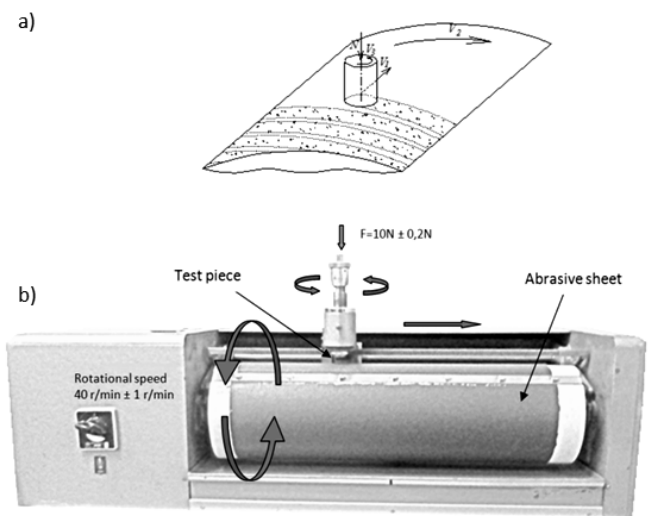
Figure 2. Schematic illustration of ( a ) the test sample sliding over the abrasive sheet and ( b ) the rotating cylindrical roller device.